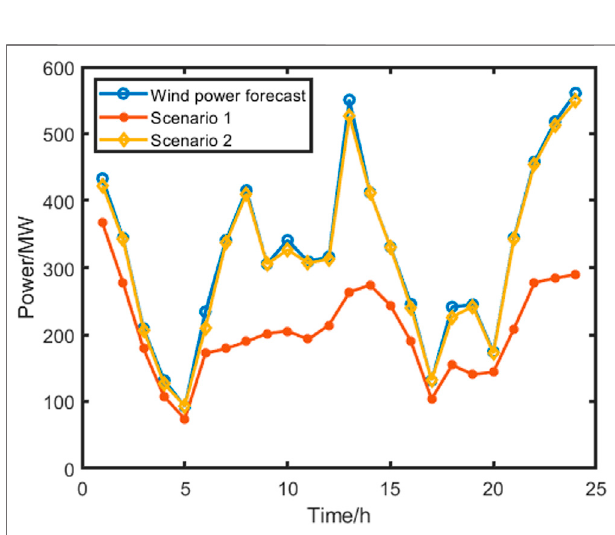
FIGURE 10 | The comparison of wind power in two